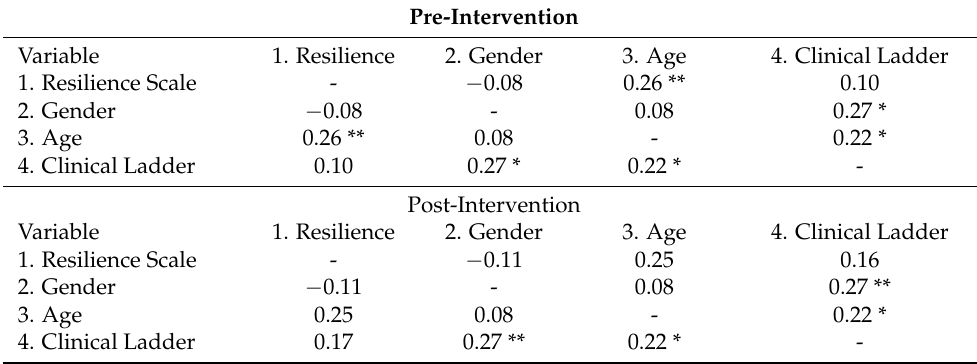
Table 5. Correlations between Resilience Scale, Gender, Age, Clinical Ladder.